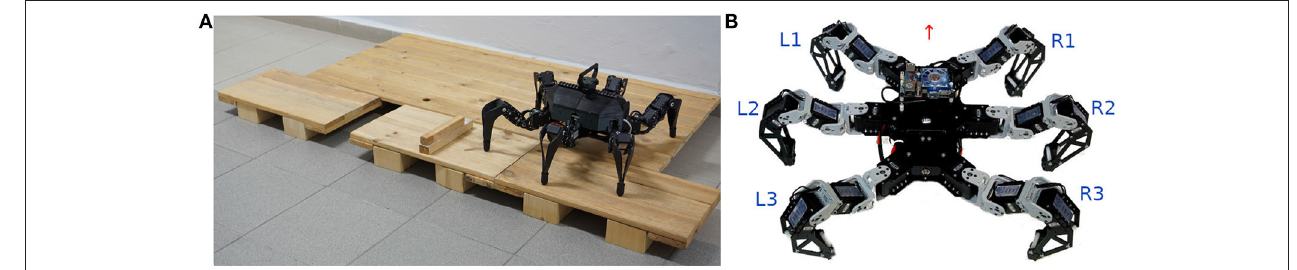
FIGURE 6 | (A) Photo of the hexapod walking robot in the laboratory test track. The robot has six legs, each comprising three Dynamixel AX-12 servomotors; however, only the body-coxa and coxa-femur servomotors are controlled in experiments presented in this work. The servomotors also provide the joint angle measurement, which is further processed into swing stop and ground contact events for each leg. (B) Leg